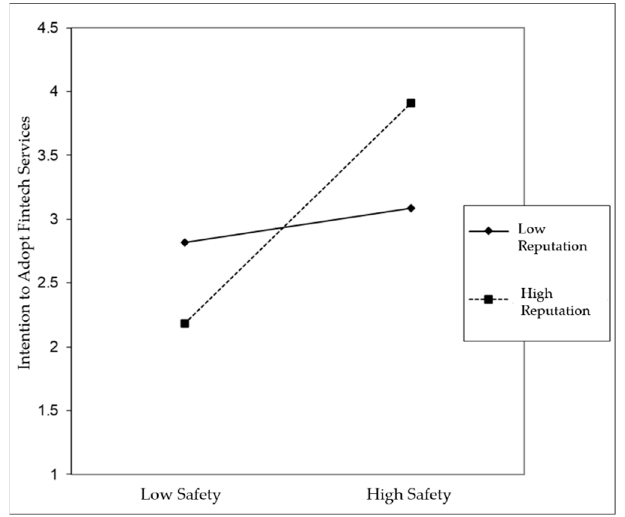
Figure 6. Interaction Perception of Reputation × Perception of Security of Fintech Services (Source: Microsoft Excel 365).